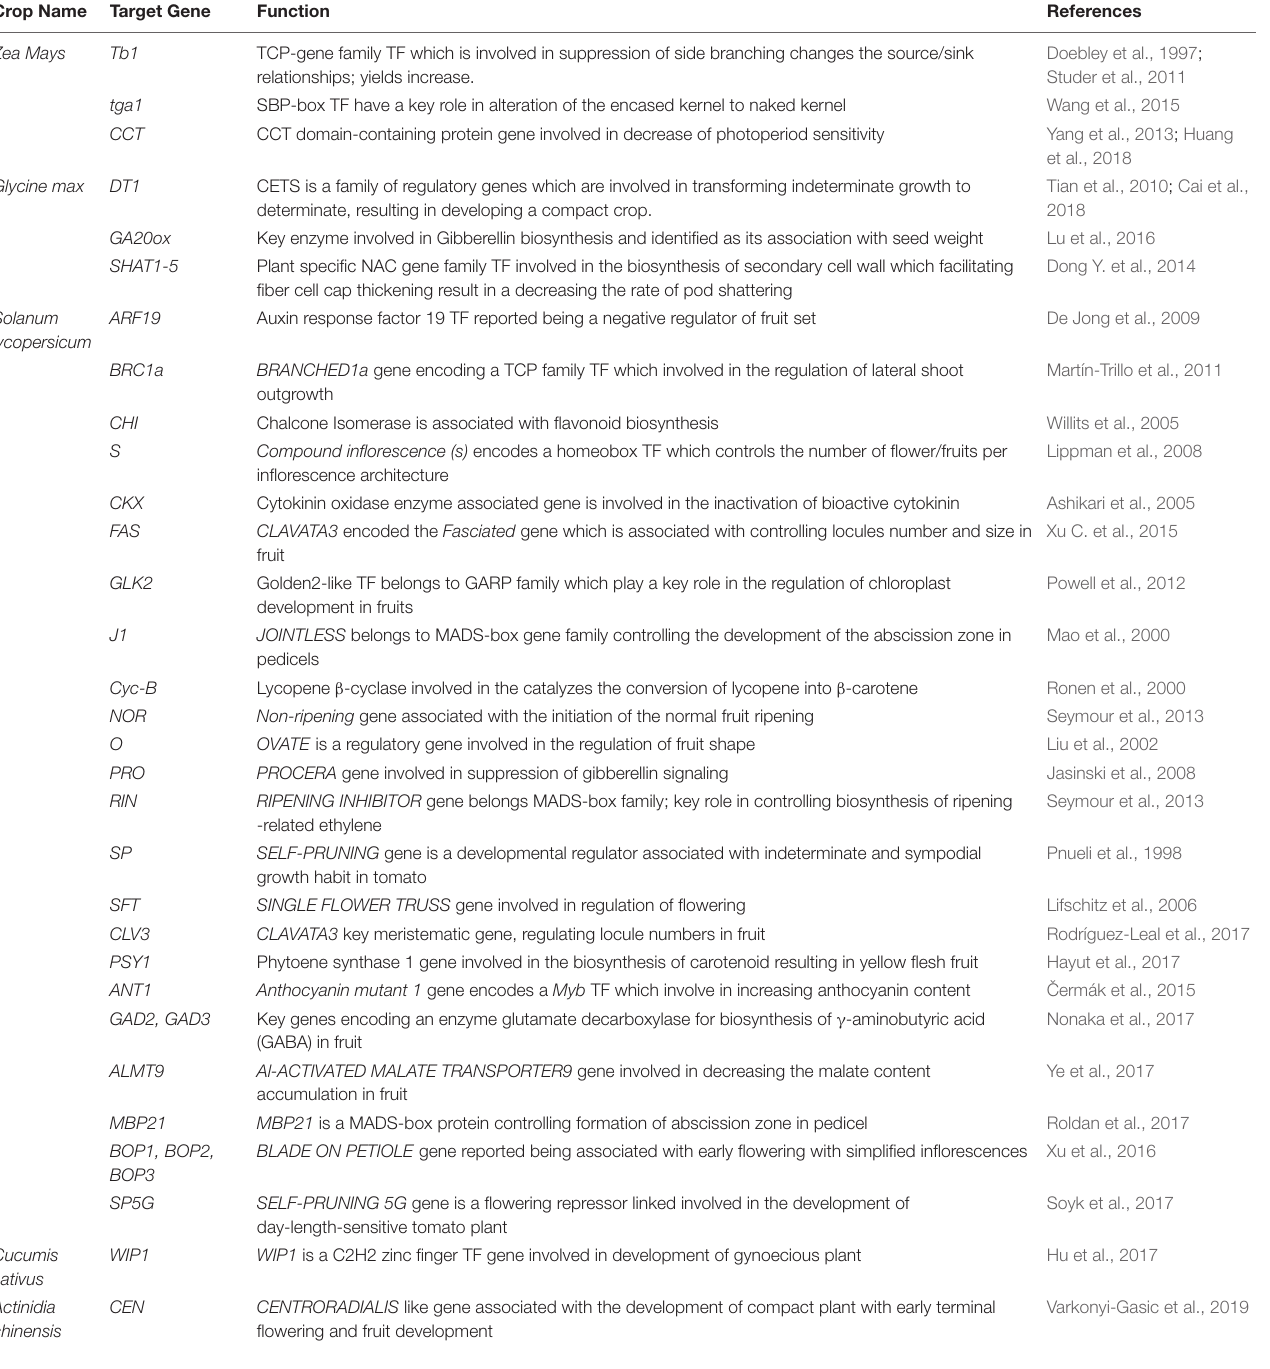
TABLE 6 | A model representing state of art for selecting the genes which can be edited to domesticate crop wild ancestral species through CRISPR/Cas9 approach. Crop Name Target